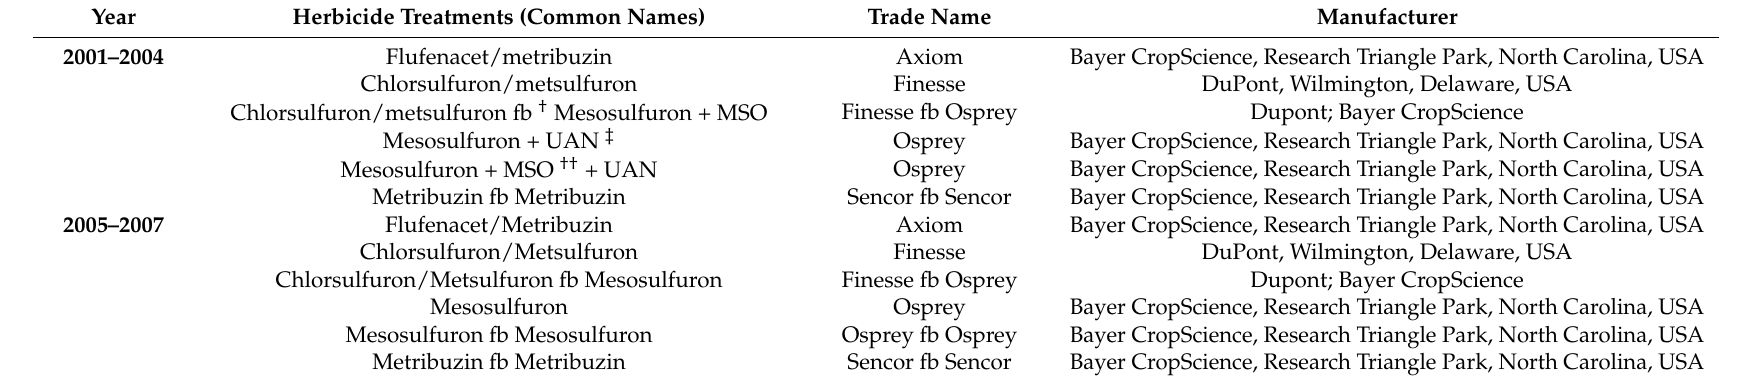
Table 2. Herbicide treatments, their trade names, and manufacturers, used in this study from 2001 to 2007.